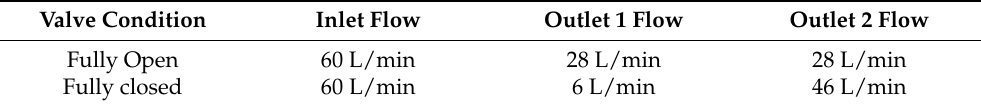
Table 3. Showing the amount of flow redirected by the actuation of the valve.